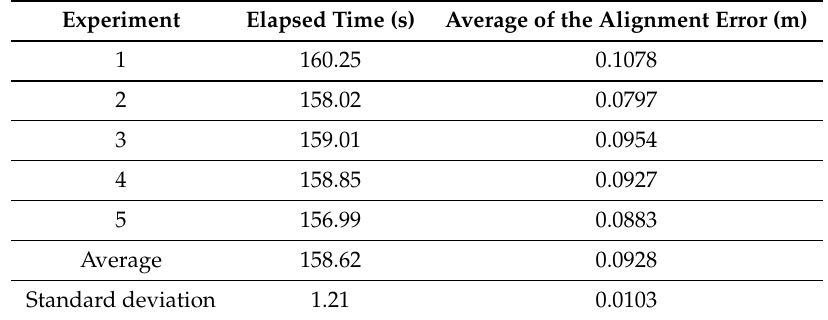
Table 7. Supervisory Mode Experiments.